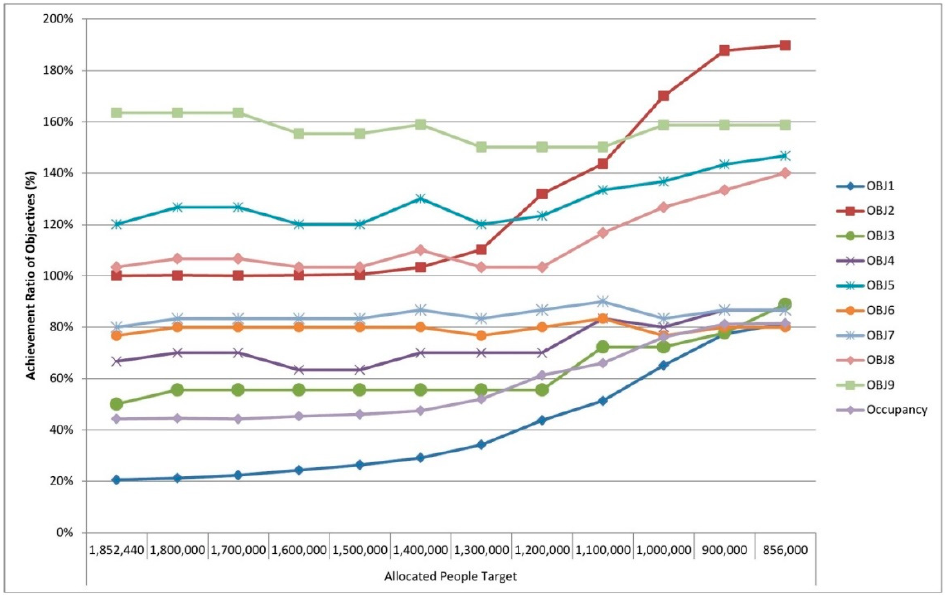
Figure 9. Achievement ratios for objectives as a result of conducting sensitivity analyses in the target of allocated people.